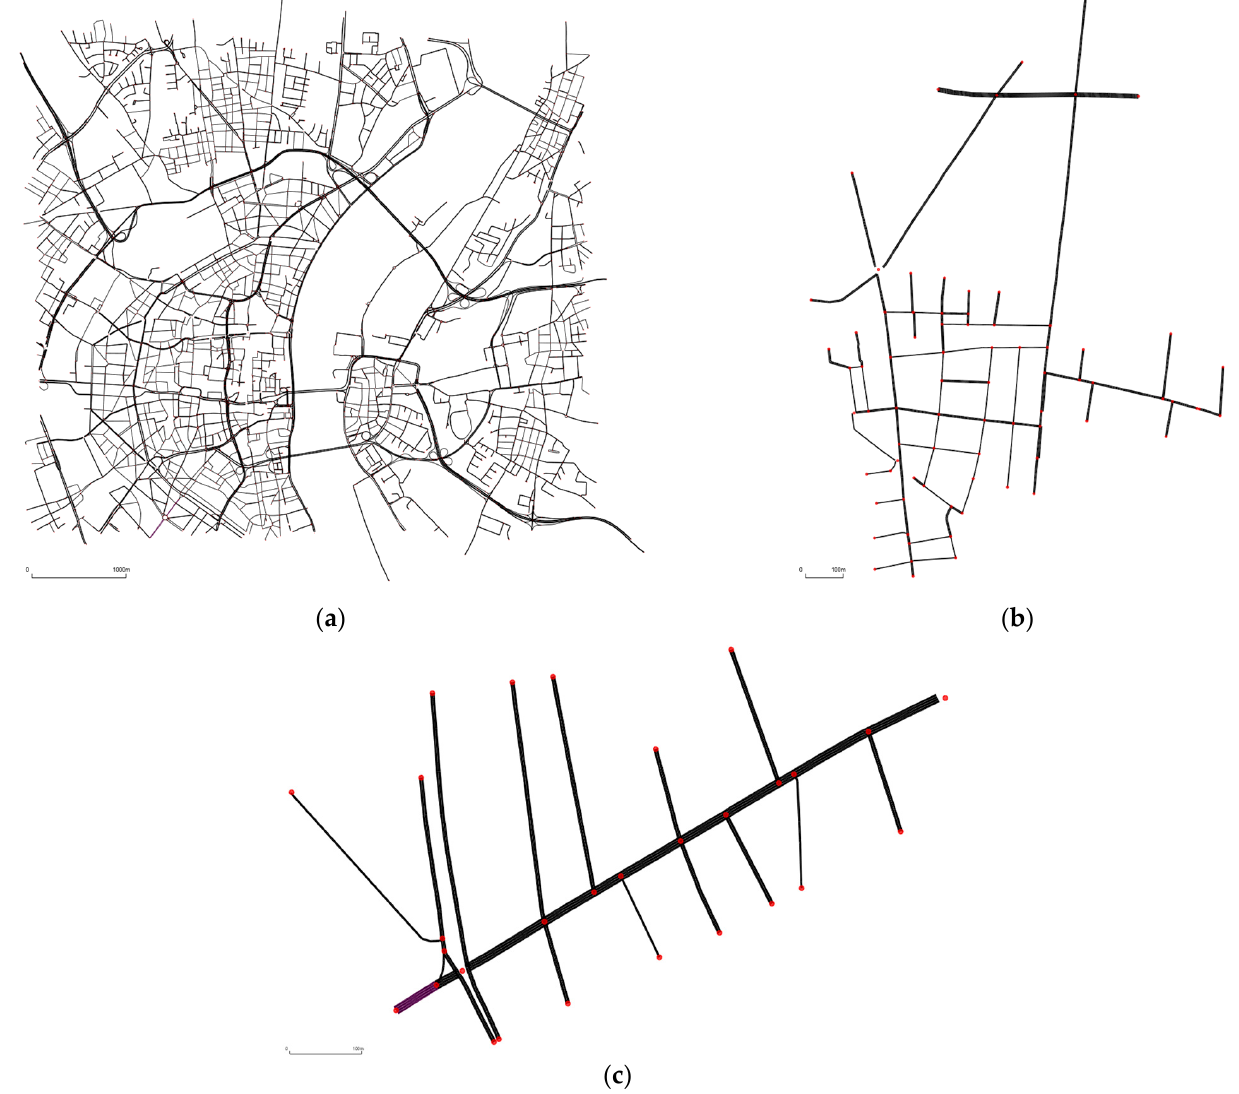
Figure 3. Road networks of the considered simulation scenarios: ( a ) “Cologne-316”: a large road network area; ( b ) “Cologne-8”: a small road network area; ( c ) “Cologne-3”: an arterial corridor. Each scenario was simulated in 10 episodes with 10 different random seeds. In